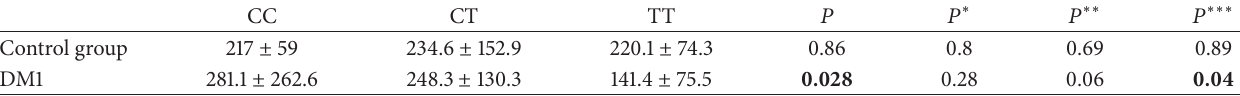
Table 2: Serum level of 17 𝛽 -estradiol in DM1 and healthy young girls differing in the IVS1 − 397T > Cestrogen receptor 𝛼 polymorphism. CC CT TT 𝑃 𝑃 ∗ 𝑃 ∗∗ 𝑃 ∗∗∗ Control group 217 ± 59 234.6 ± 152.9 220.1 ±